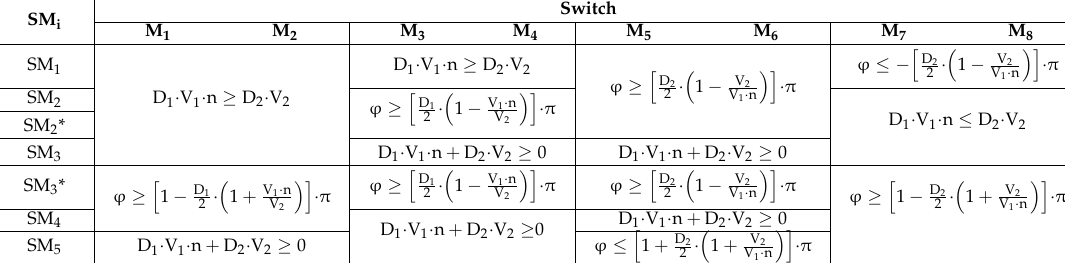
Table 4. Case I (v 11 ≥ v 22 and D 1 > D 2 ): General conditions to obtain Zero voltage switching (ZVS) and Zero current switching (ZCS) for each